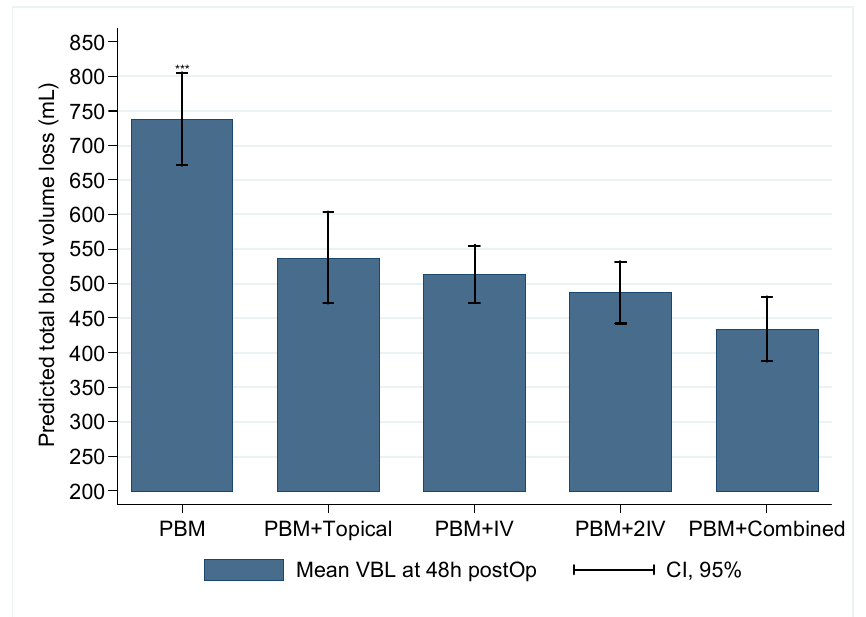
Figure 3. Comparison of predicted total blood volume loss at 48 h postop among groups of treatment, adjusted by the rest of the variables in the model. *** Difference (Wald’s test) between the PBM group with each TXA group ( p < 0.001, ß > 95%). No differences were found in comparisons between PBM + Topical / PBM + IV ( p = 0.971, ß = 99%), PBM + Topical / PBM + 2IV ( p = 0.260, ß = 26%), PBM + Topical/PBM + Combined ( p = 0.766, ß = 78%), PBM + IV/PBM + 2IV ( p = 0.268, ß = 14%), PBM + IV/PBM + Combined ( p = 0.244, ß = 74%), and PBM + 2IV/PBM + Combined ( p = 0.975, ß = 31%). Table 3. Generalised linear model analysis of the association of regimen of treatments with total blood volume loss at 48 h postoperative, adjusted for covariates.